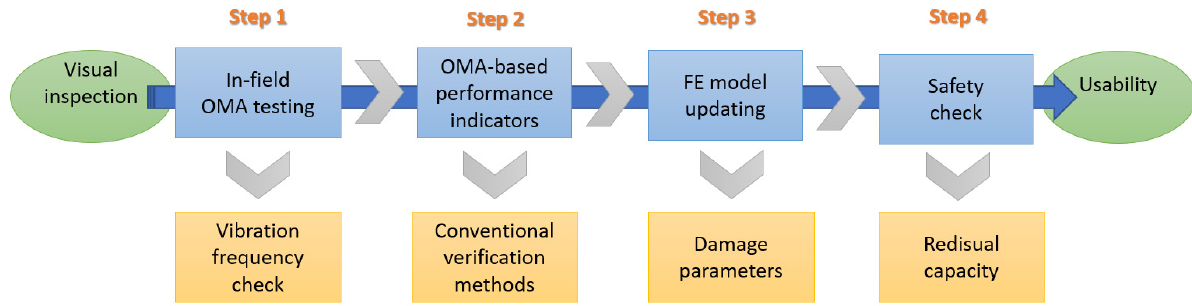
Figure 3. Proposed procedural steps for safety and residual capacity assessment of existing, in-service LG pedestrian systems.